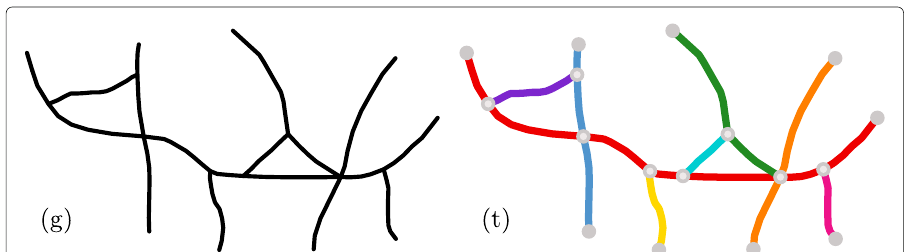
Fig. 1 Notional urban street network 1 in black-and-white and colourized versions used all along the paper. This notional example is meant to pattern a portion of a real-world city map. The black-and-white version (g) connotes a geometrical viewpoint that leads to a Poissonian physics. Whereas the colourized version (t) evinces a topological perception that is subject to scale-free